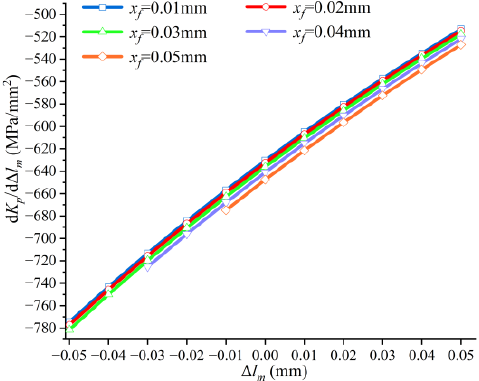
Figure 29. Pressure gain robustness against width error of shunt wedge.